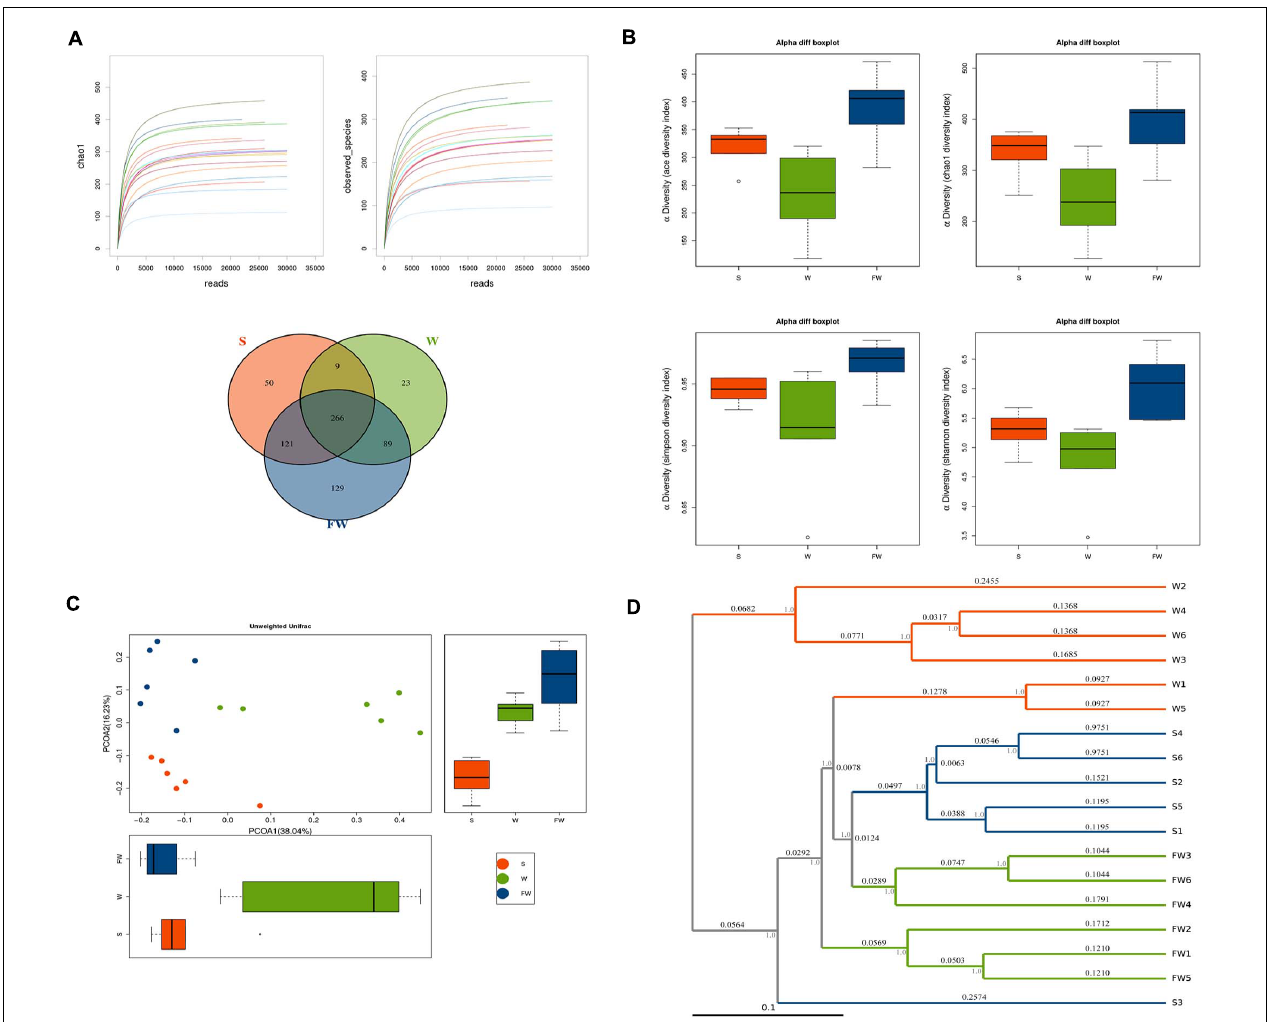
FIGURE 9 | Richness and biodiversity of Intestinal Microbiota. (A) Rarefaction curves determined at the 97% similarity level and Venn diagram of OTUs in the three groups. (B) α -diversity indexes of bacterial community. (C) Scatter plots obtained from PCoA based on the unweighted UniFrac. (D) UPGMA hierarchical clustering analysis based on the unweighted UniFrac (S, Sucking; W, Weaned; FW,